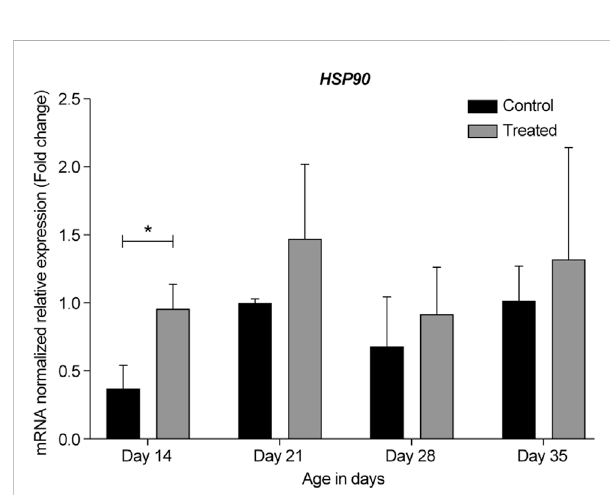
FIGURE 10 ΔΔ Ct oftherelativenormalizedexpressionfor HSP90 inthecontrol (indoor) group and heat-treated (outdoor) chickens at 14-, 21-, 28-, and 35-days of age in the summer of 2021 ( n = 3 in each group, * p < 0.05). HSP, heat shock